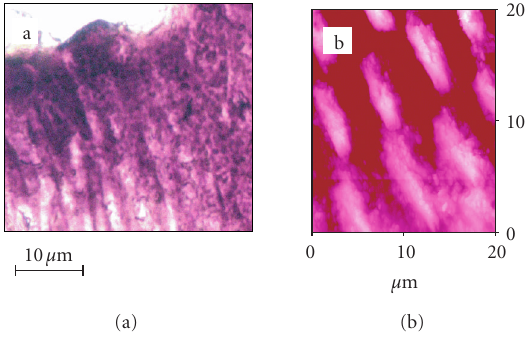
Figure 19: Shear-force AFM (a) (3.5 μ m, Z range 100nm) and aper- tureless SNOM (b) of a cryomicrotome cut of a rabbit heart show- ing lamella structures and a lysosome (bright membrane and dark interior optical contrast to the right). The various organelles show very diversely structured optical contrast in line with highly varied chemical di ff erences at the corresponding sites.